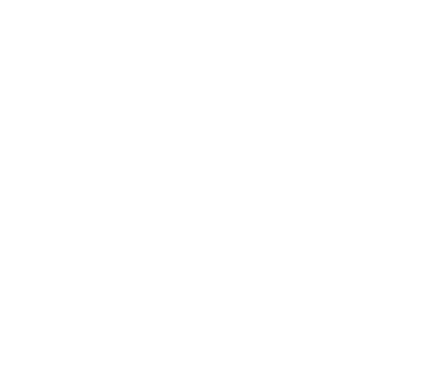
Figure 6. XPS spectra of Mo3d for the prepared Mo 2 C/Ni-incorporated carbon nanofibers obtained from 25 wt% molybdenum chloride electrospun solution and calcined at 850 °C.